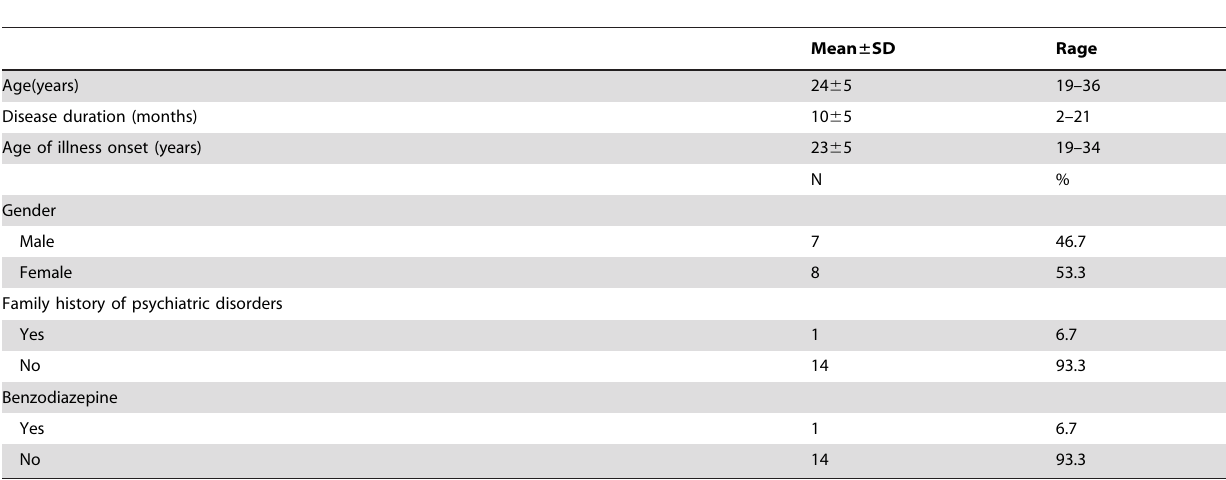
Table 3. Demographic characteristics of the patients selected for gel analysis (N